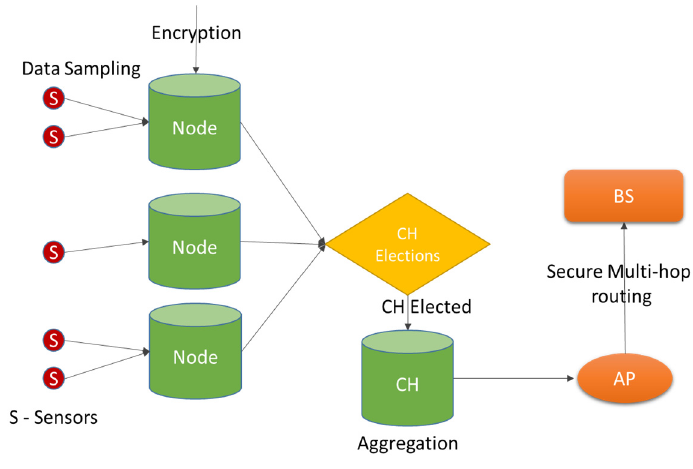
Figure 1. System model.